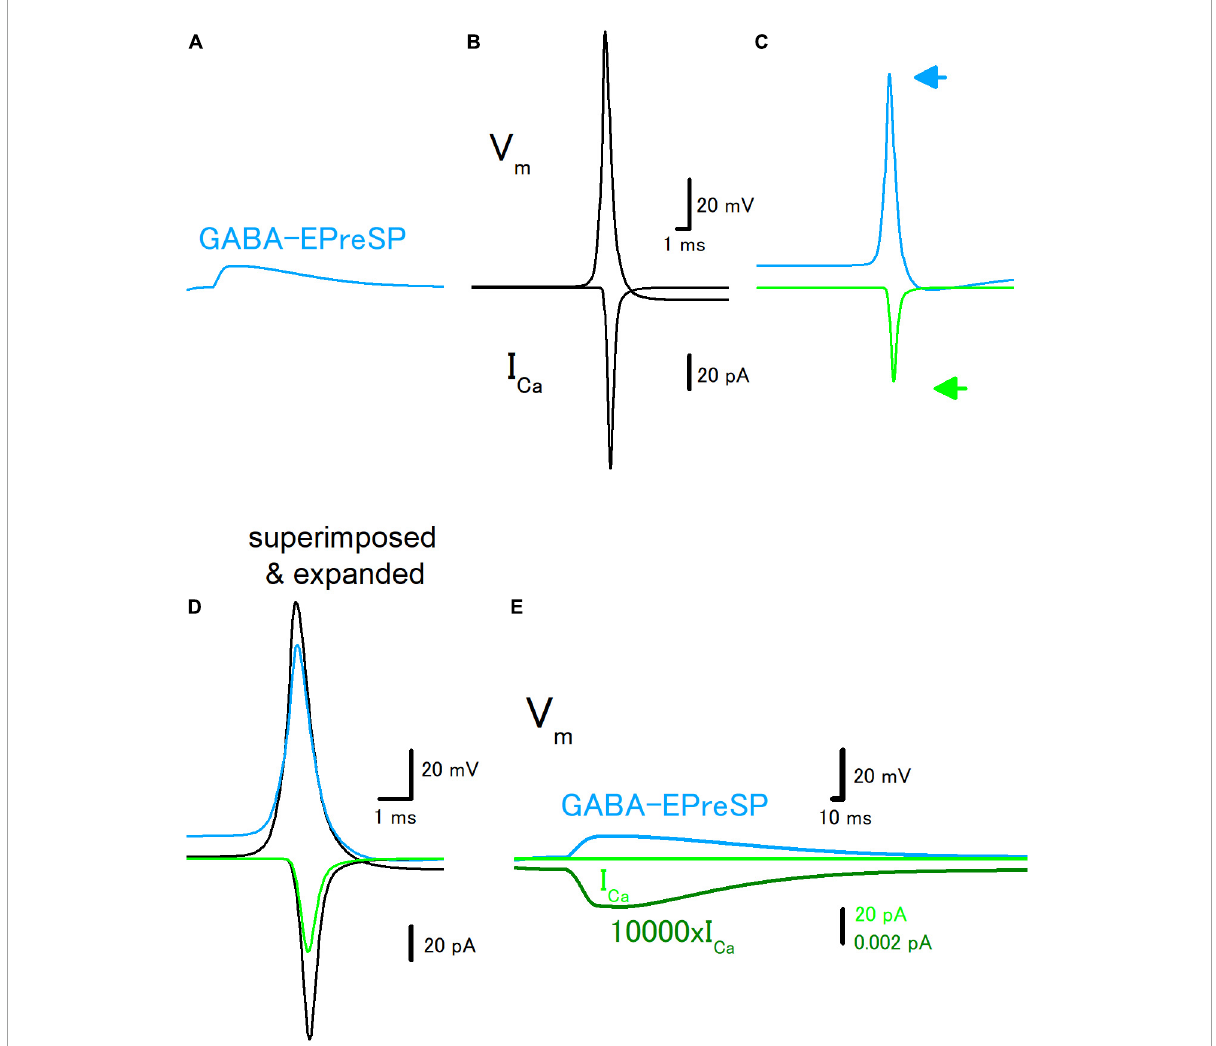
FIGURE4 Effects of GABA-EPreSP on the propagating action potential and presynaptic calcium current. (A) Simulated depolarizing GABA-EPreSPs (blue) elicited by the activating presynaptic GABA A receptors assuming the reversal potentials of − 52 mV positive than the resting membrane potentials. (B) Simulated propagating action potential (V m : upper) and presynaptic calcium current (I Ca : lower) of the first mossy fiber bouton of the main trunk in the control condition. (C) Propagating action potential (blue) and presynaptic calcium current (green) were calculated with the preceding GABA-EPreSPs elicited by stimulation of presynaptic GABA A receptors. The synaptic conductance was set to evoke somatic EPSPs of approximately 20 mV. (D) Superimposed and time expanded traces of propagating action potential and presynaptic calcium current. (E) Subthreshold GABA-EPreSP (blue)-induced presynaptic calcium current (green) that magnified 10,000 times (dark